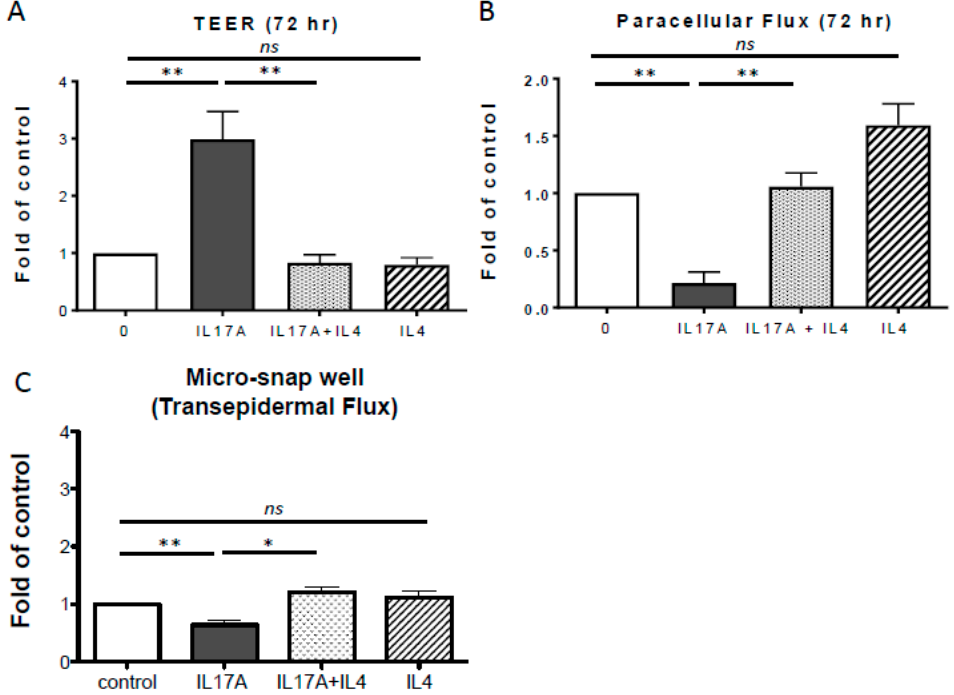
Figure 2. IL-4 inhibits IL-17A mediated barrier enhancement in PHK. Co-treatment with IL-4 (50 ng / mL) ( A ) inhibited IL-17A (100 ng / mL) increased TEER and ( B ) enhanced paracellular flux ( n = 3–5). ( C ) IL-17A treatment reduced transepidermal flux of fluorescein (50 ng / mL 0.02% fluorescein; n = 3) in tape-stripped human skin samples. Data are shown as mean ± SEM fold of control. * p ≤ 0.05, **